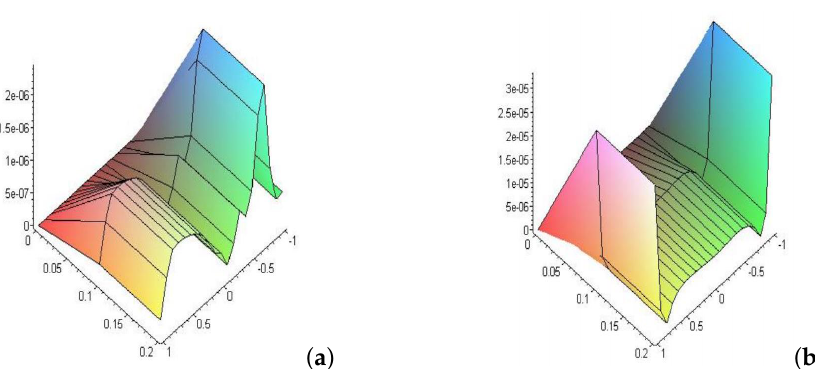
Figure 3. ( a , b ) Shows the error of Equation (44) respectively for the nonlinear and linear cases of Carleman coefficients at t = 0.2 and N =